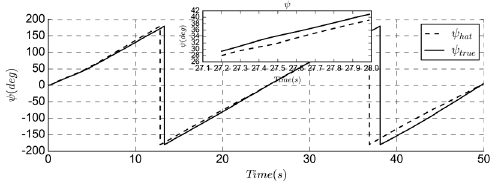
Figure 6. Comparison of true and estimated yaw angle.